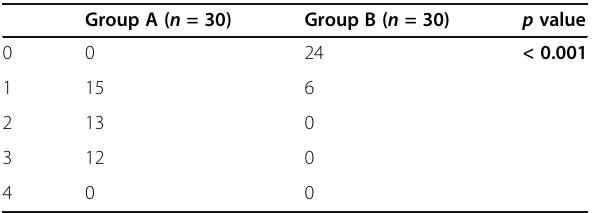
Table 3 Grade of